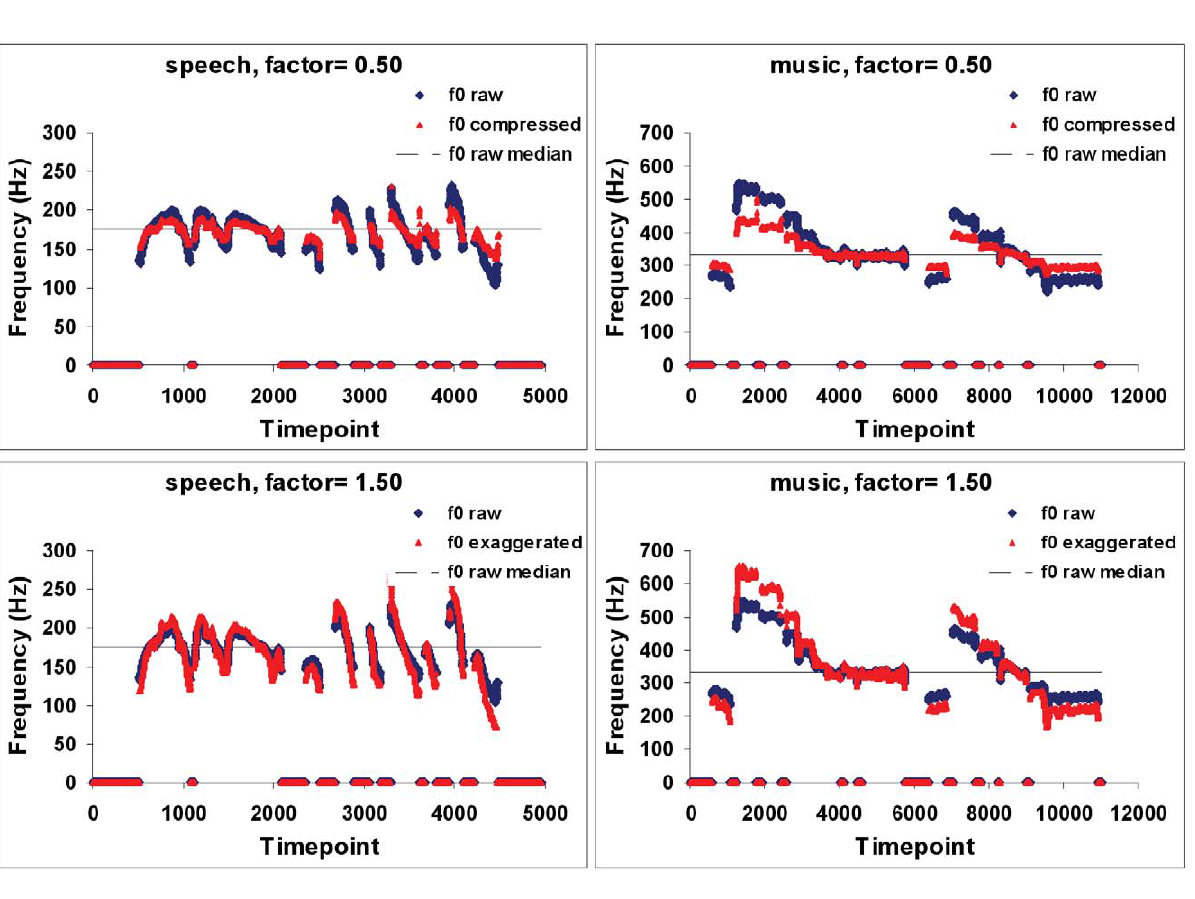
Figure 2. Each panel represents the fundamental frequency (F0) contour of a spoken utterance (left side of figure) or of sung speech (right side of figure). Note the more continuous F0 contours for speech compared to the more discrete contours for song. The blue traces are the original contours, while the red ones represent distortions in which the F0 was either compressed by 50% (top panels) or exaggerated by 50% (bottom panels). The associated sound files illustrate that the manipulation of F0 on the speech sample (Sounds S1, S2, S3) has little perceptual effect, since it continues to sound natural (in fact, the change is hardly detectable). In contrast, the same degree of F0 distortion on the music (Sounds S4, S5, S6) is readily noticeable, as the familiar melody sounds obviously out of